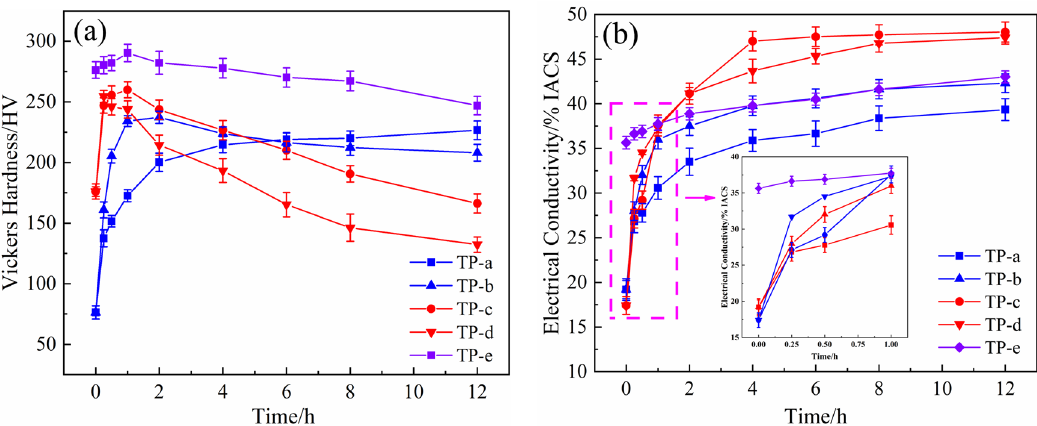
Figure 3. Hardness and electrical conductivity of the NS-4 alloy with di ff erent combined aging treatments. ( a ) Hardness and ( b ) electrical conductivity.